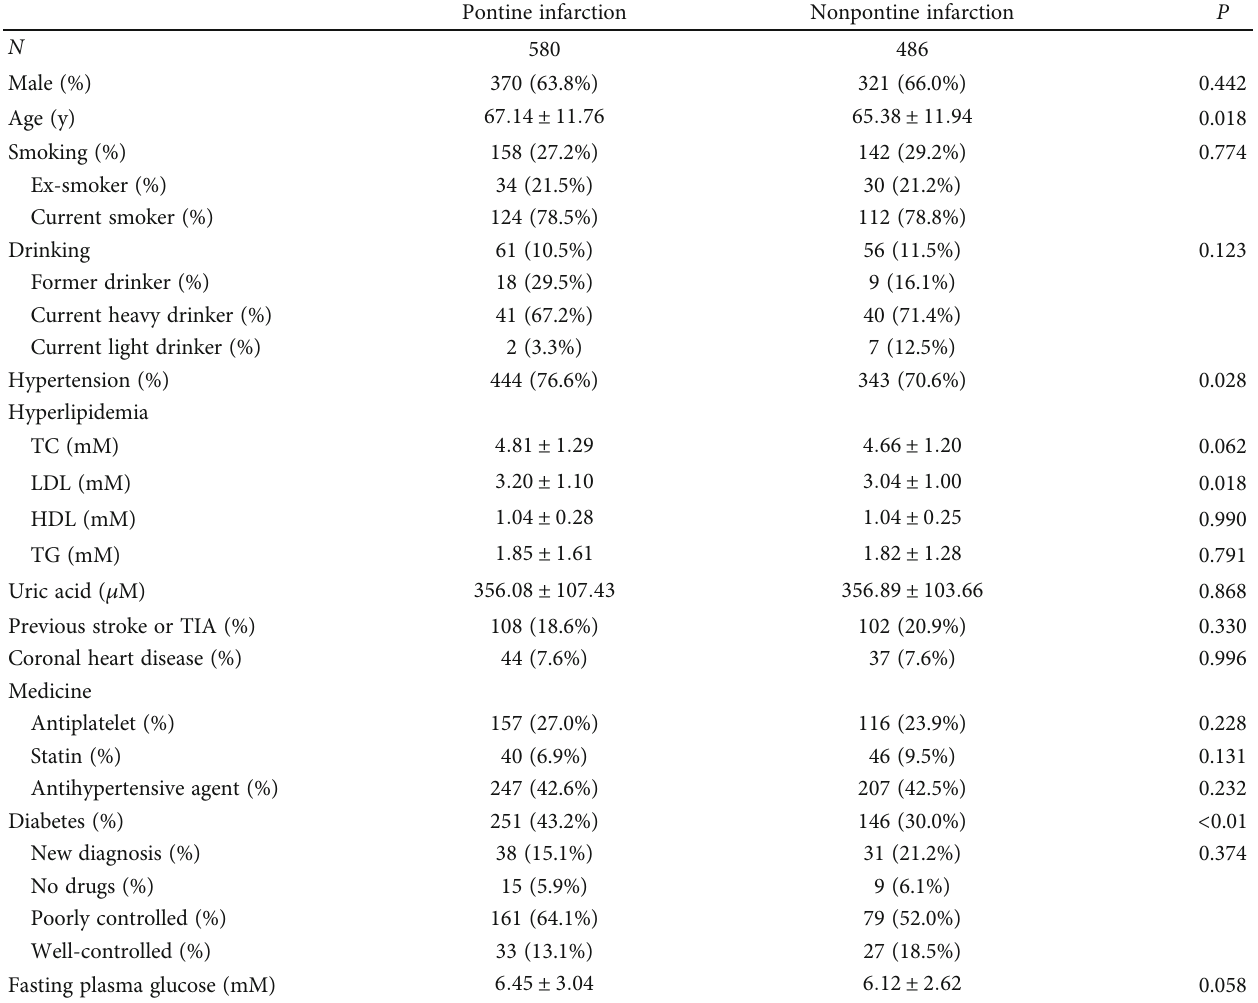
Table 3: Pontine infarction vs. nonpontine infarction with